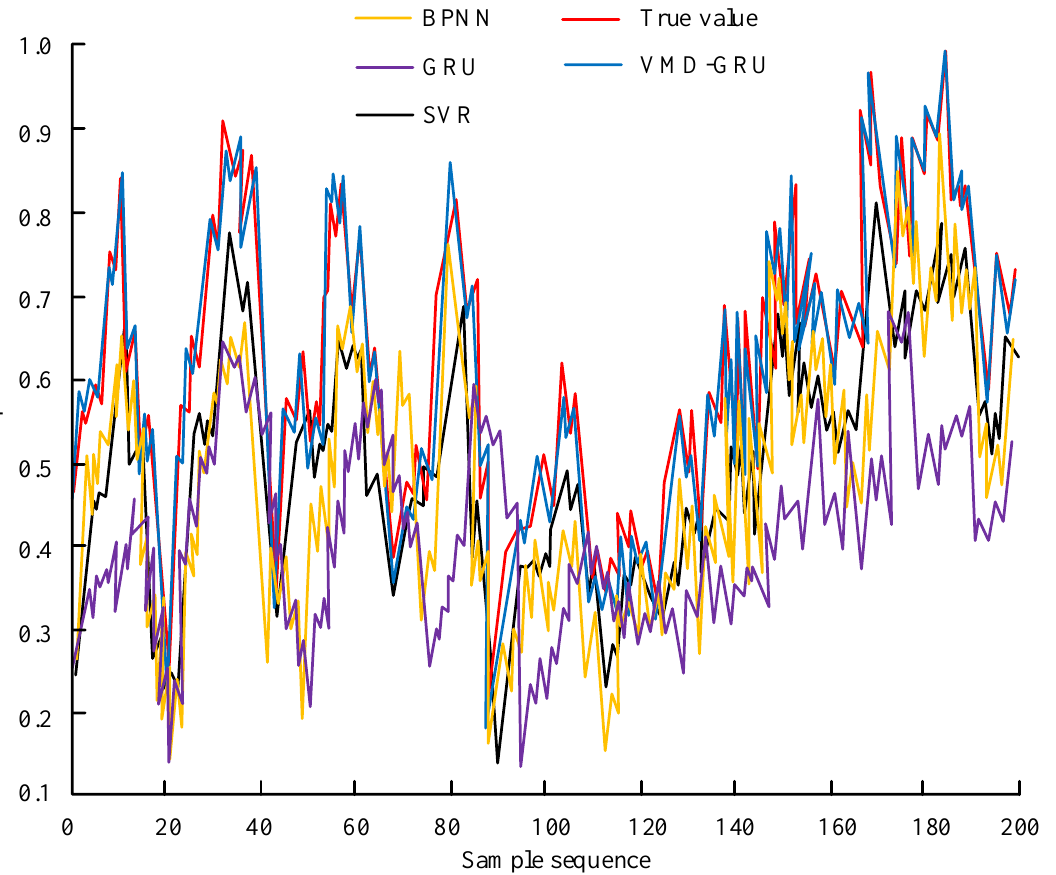
Figure 10. Comparison of the difference between the predicted value and the real value under different algorithm models.